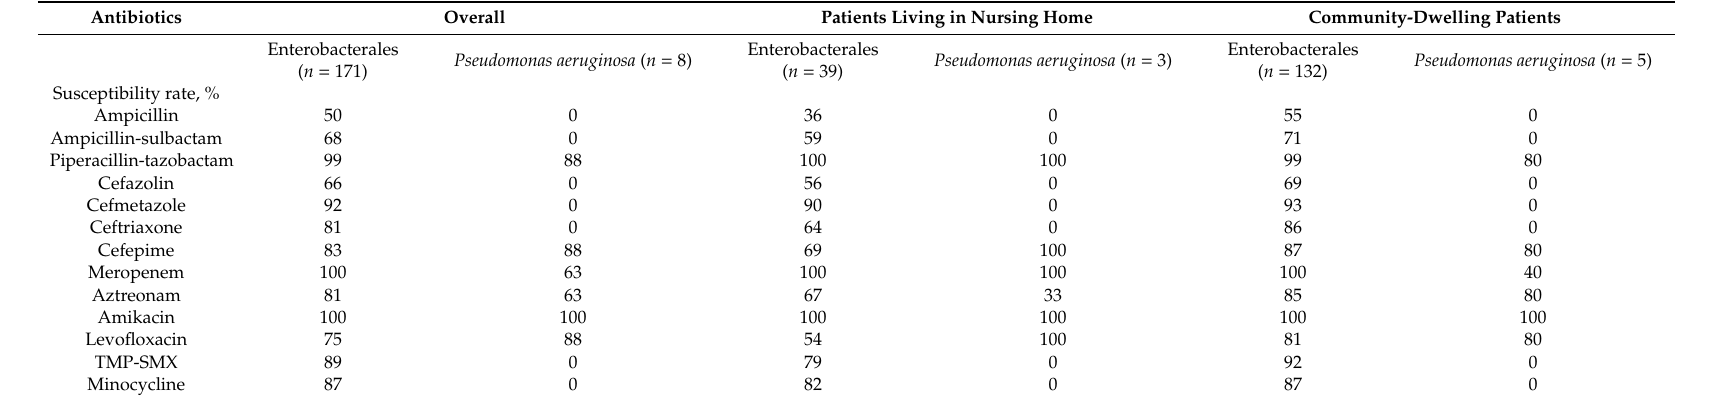
Table 3. Antibiotic susceptibility pattern of isolates from nursing home residents and community-dwelling